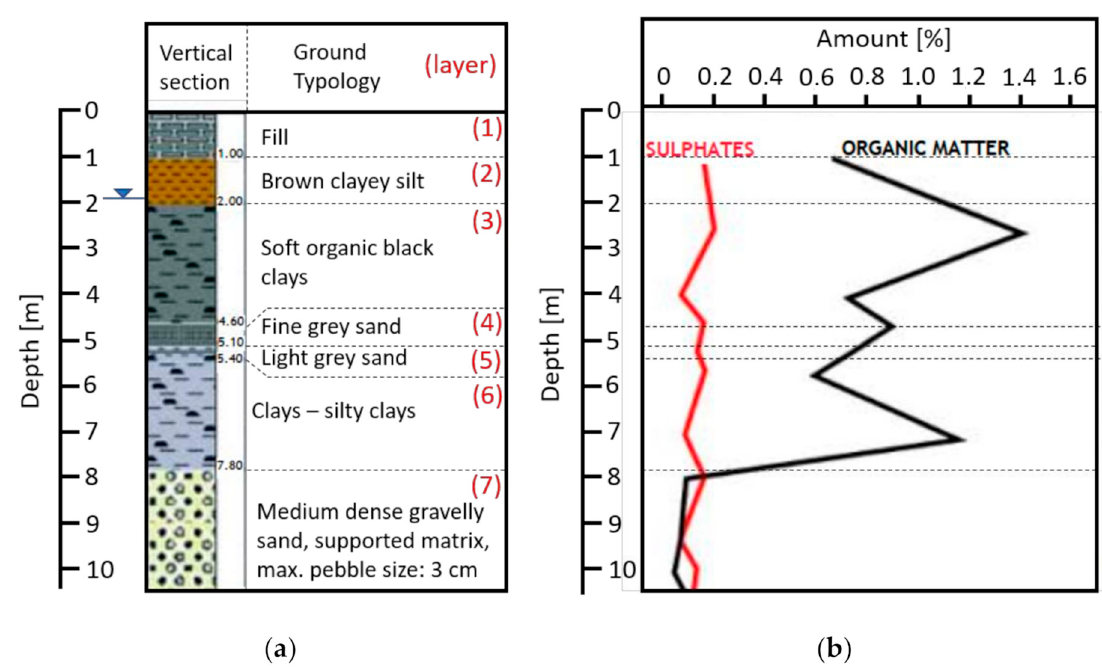
Figure 4. ( a ) Lithological column at the test site. ( b ) Results of the organic content analysis.